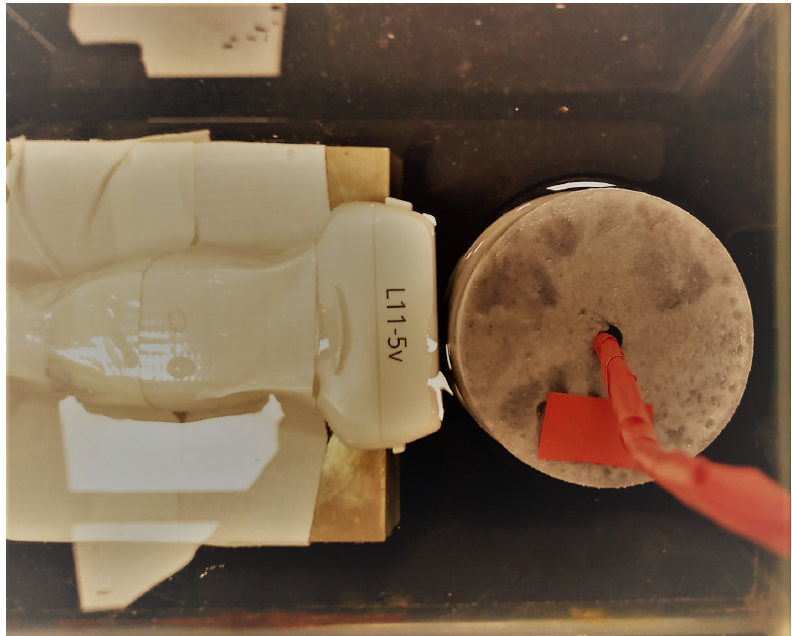
Figure 4. Experimental setup for ultrasound tracking of the shear waves generated by the trans- luminal emitter in phantom A. The ultrasound probe was located at the same plane where the transluminal sensor was placed during the transluminal Transmission–Reception (T–R) tests. The red rectangle shows the location of the stiffer